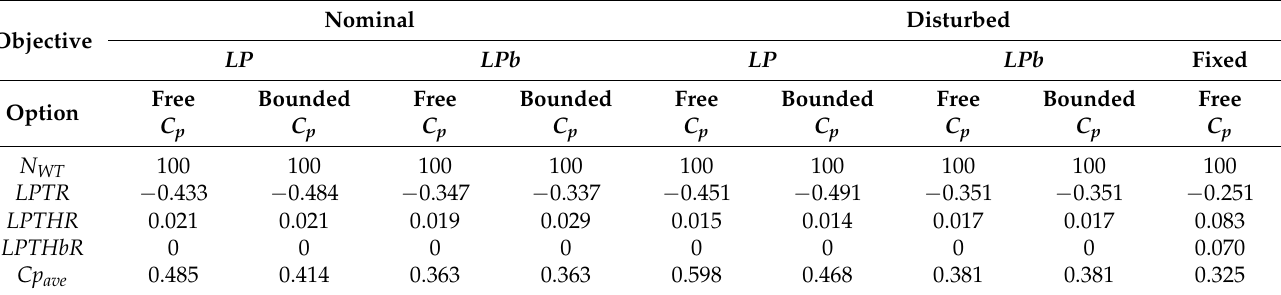
Table 2. Results of the instantaneous control for one-day